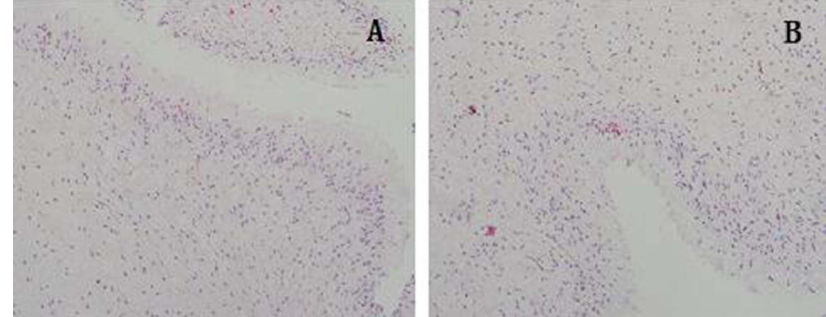
Figure 6- Micrograph of pulp tissue after HE staining ×200. (A: control group; B: laser group, 0.5 W , 167 J/cm 2